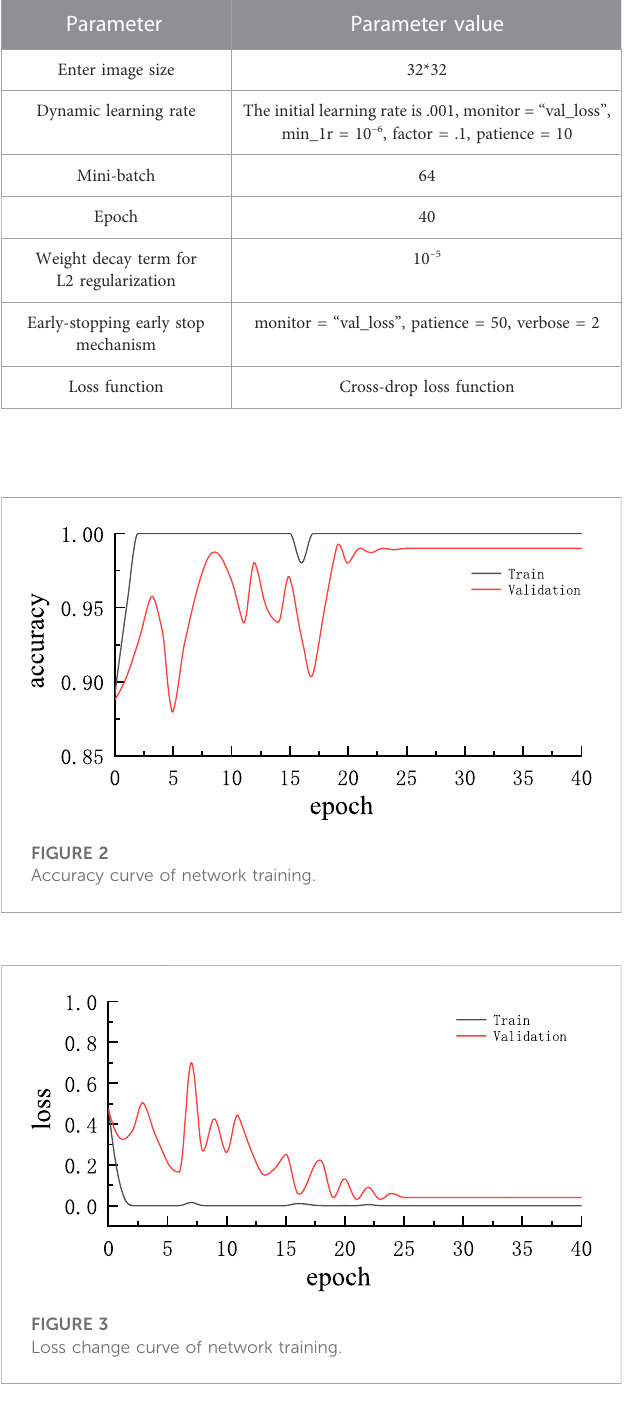
TABLE 5 Setting of network training parameters.